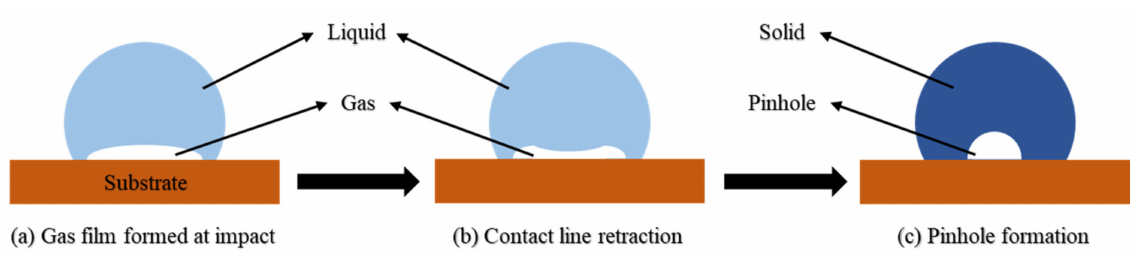
Figure 2. Schematic of bubble evolution during droplet